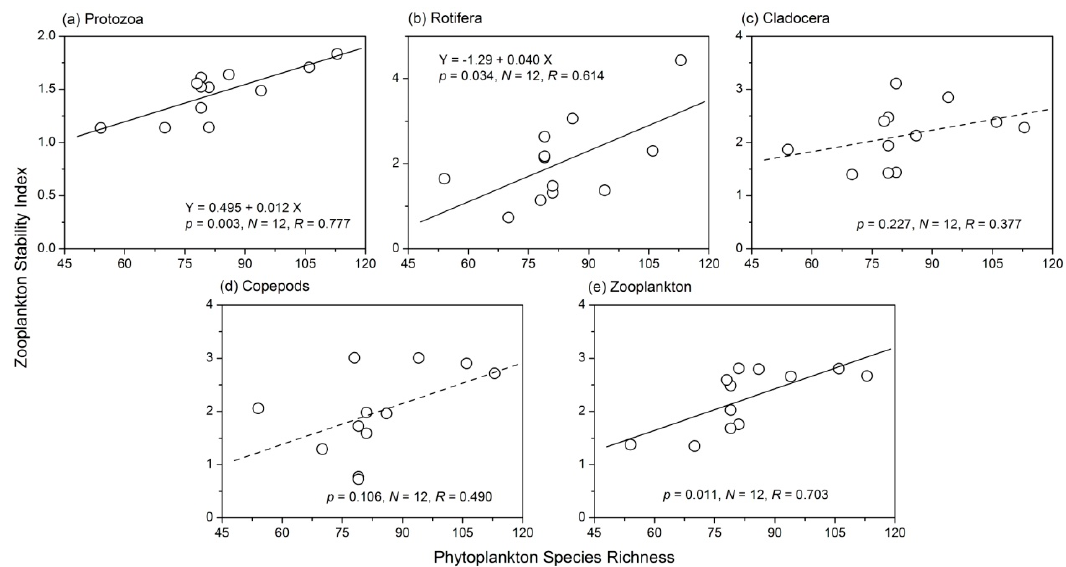
Figure 7. Relationships between phytoplankton species richness and the stability of ( a ) protozoa, ( b ) rotifer; ( c ) Cladocera; ( d ) copepods and ( e ) zooplankton stability.